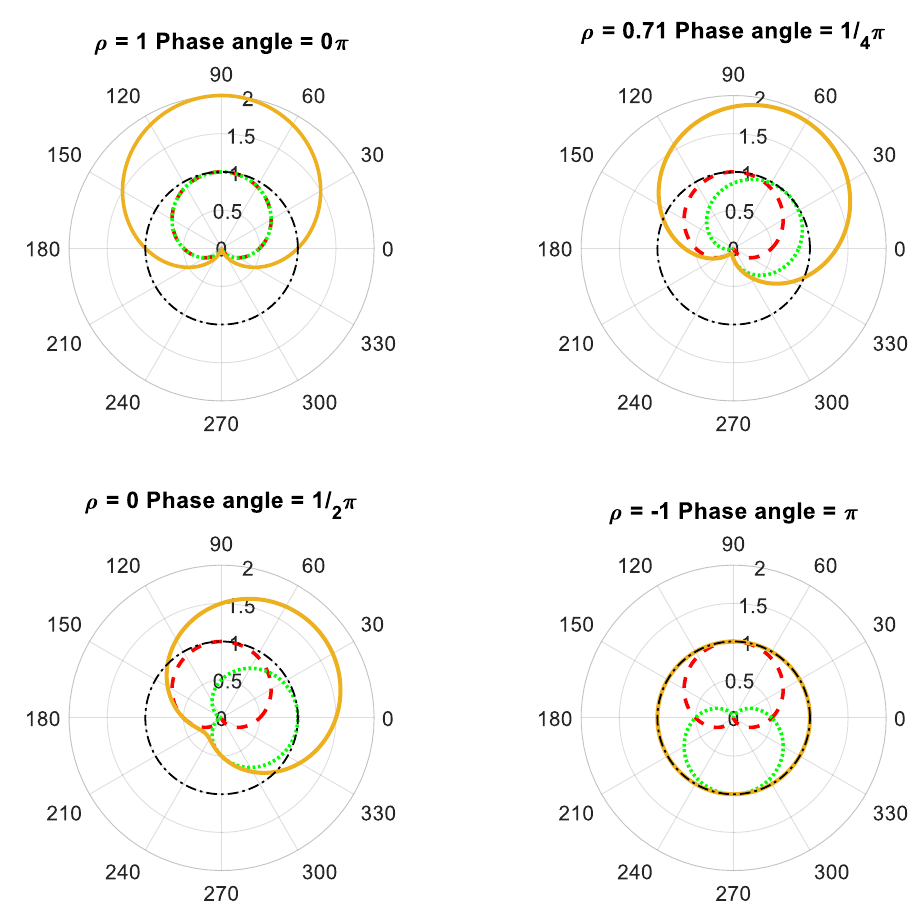
Figure 1. Representation of four different scenarios in which two renewable energy power plants (red and greed dotted and dashed lines, respectively) exhibit different complementarity (here expressed as Pearson coefficient of correlation— ρ ). The phase angle represents the angular shift between two sine functions. The continuous (orange) line represents the joint energy generation from the two energy sources, whereas the dot-dash (black) line indicates a theoretical constant load. If the orange line is above, it indicates an energy generation surplus, and when it is below, energy demand is greater than supply, and energy deficits occur.